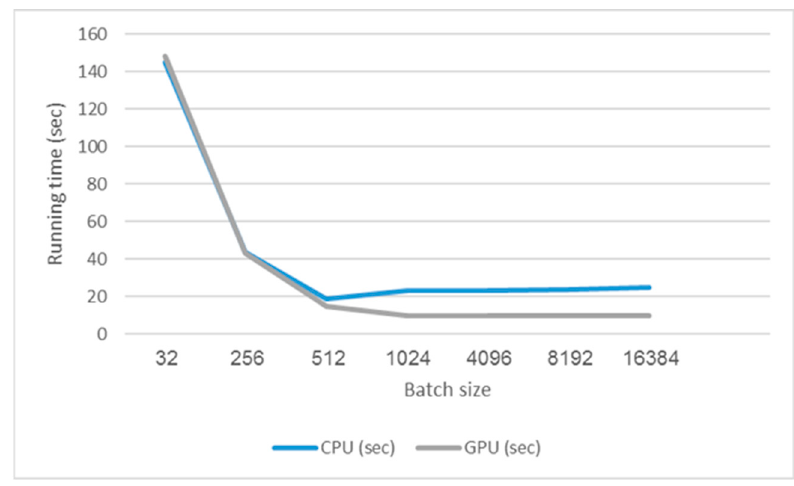
Figure 2. GPU vs. CPU running